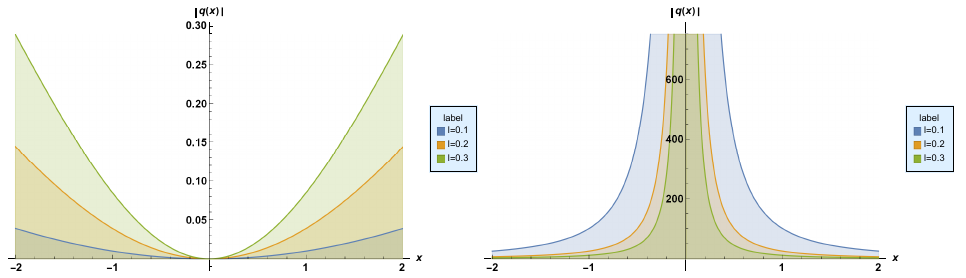
Figure 3. Profiles of stationary dark and singular solitons, respectively.